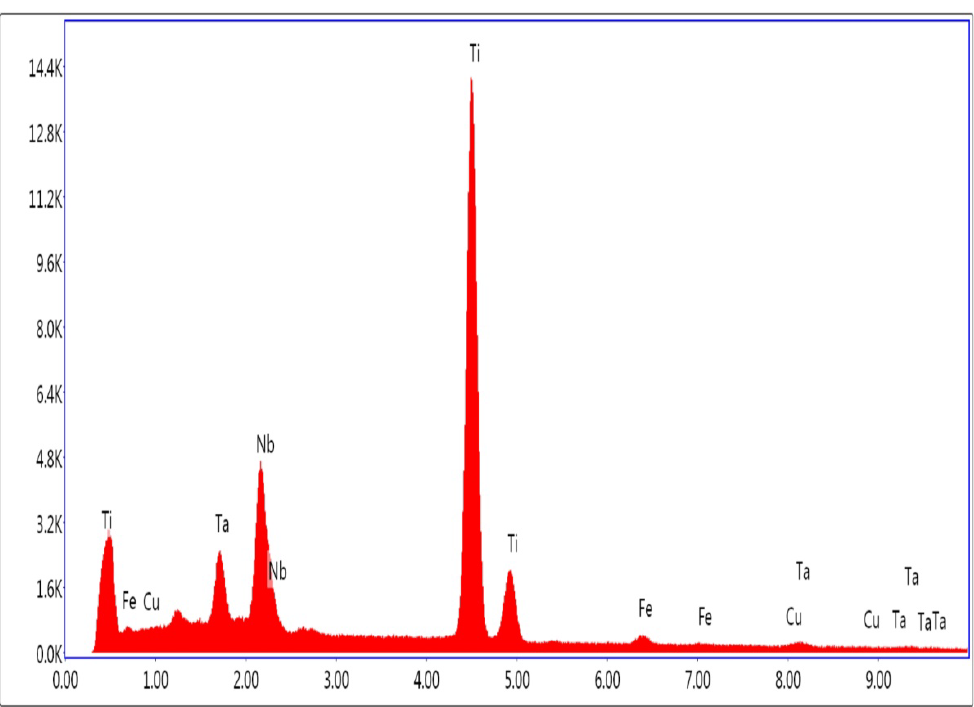
Table 1. Proportion of each element in the laser cladded sample.